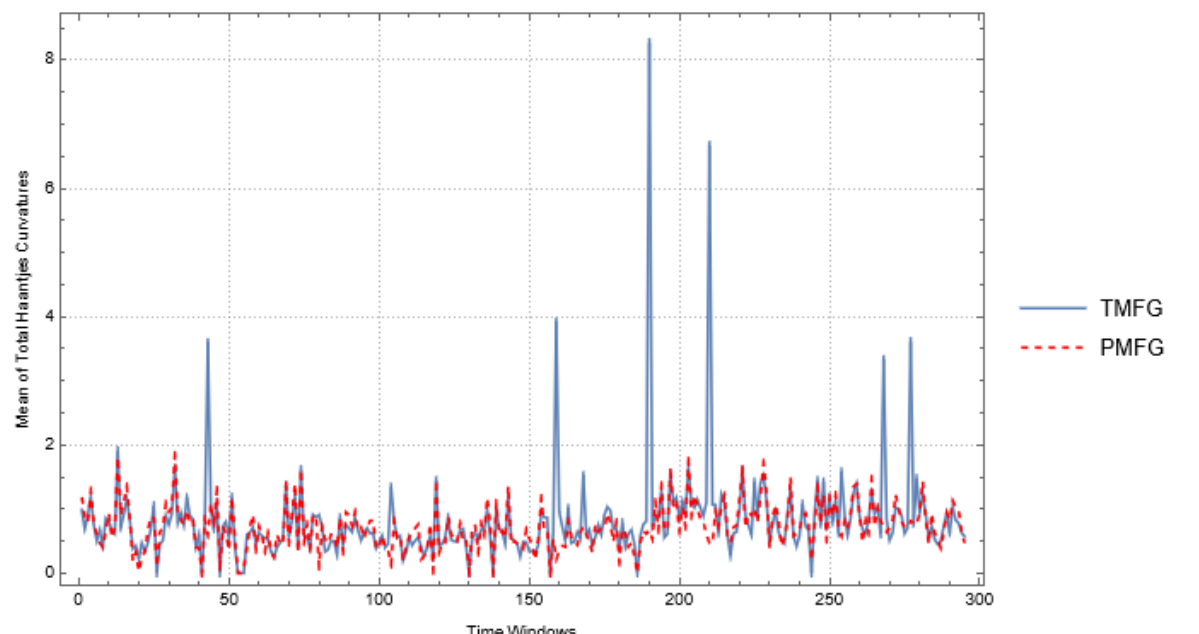
Figure 4. Means of total Haantjes curvatures of VDG of 𝐺 (cid:3021)(cid:3037) for FTSE100 using TMFG and PMFG filtrations.